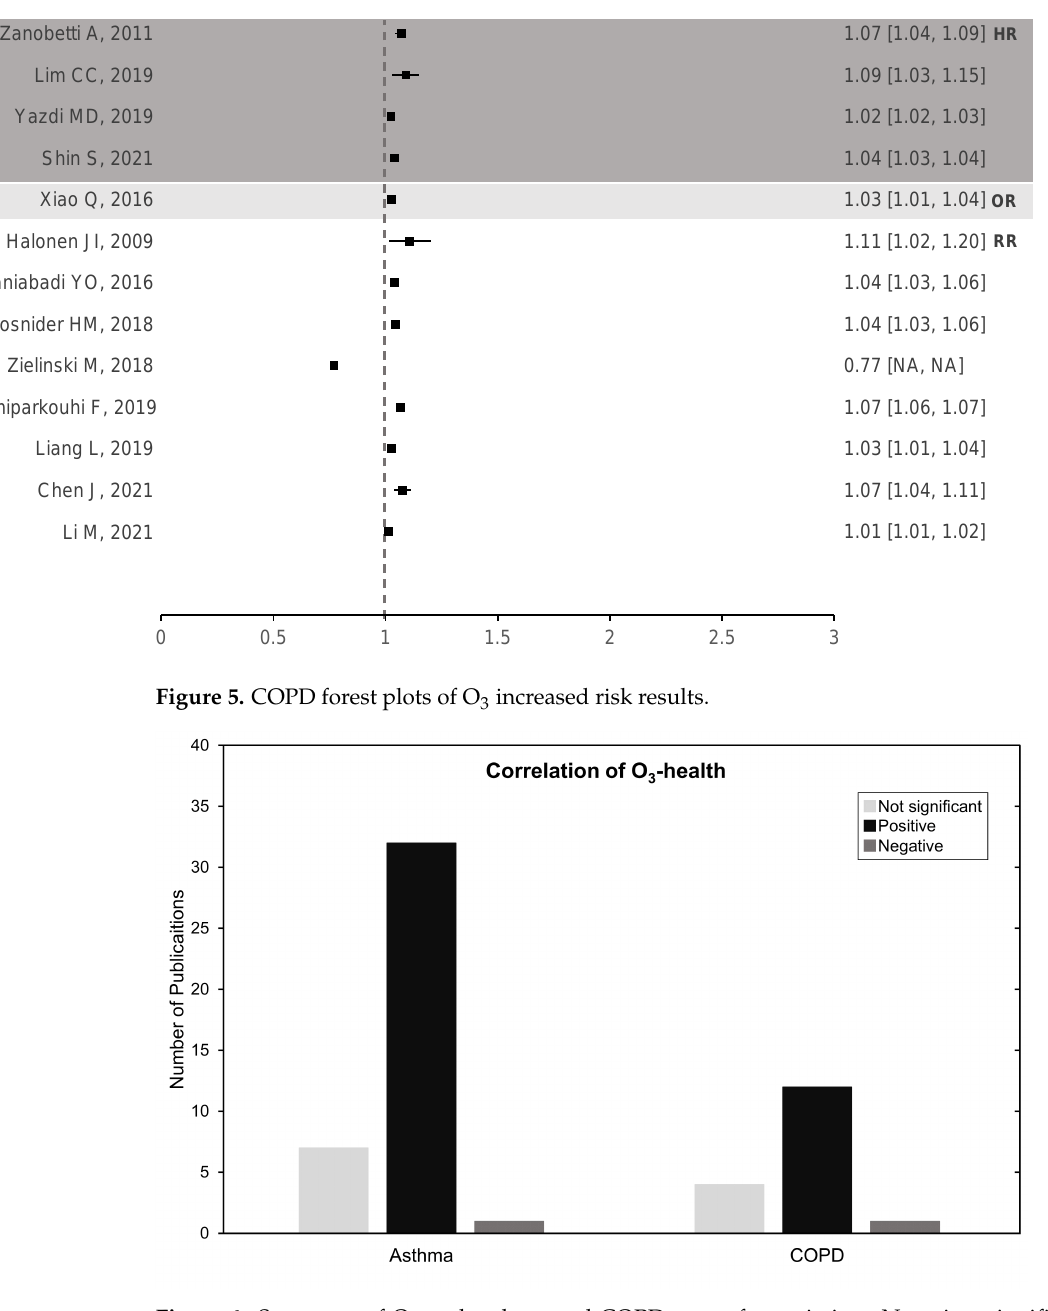
Figure 6. Summary of O 3 and asthma and COPD type of association. Negative, significant and not